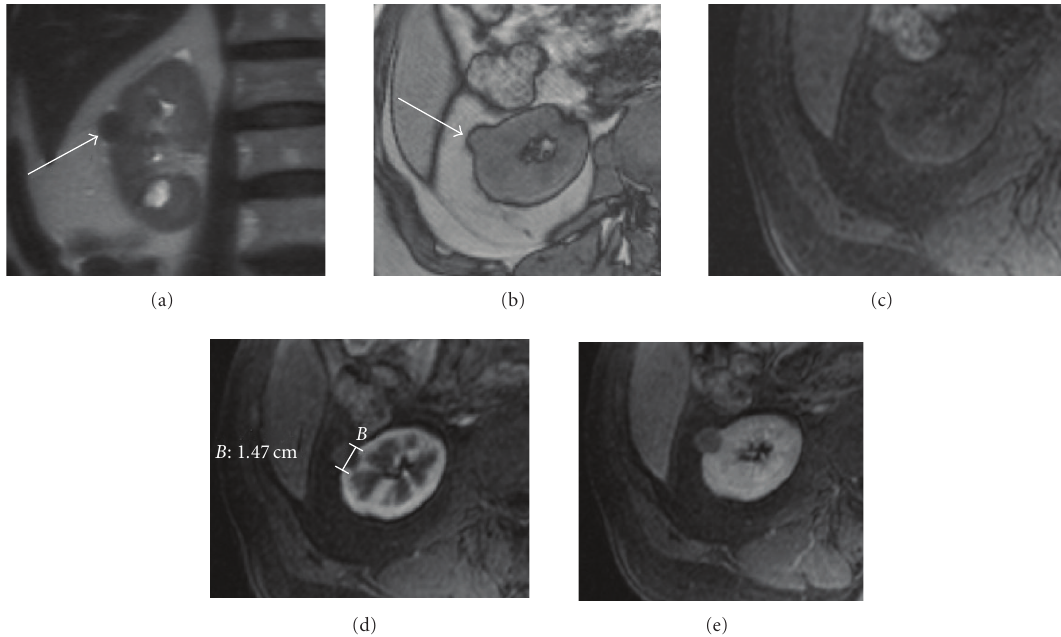
Figure 15: (a) Cor haste T2, (b) out of phase axial T1, (c) axial precontrast T1 with fat suppression, (d) early postcontrast axial T1 with fat saturation, and (e) axial postcontrast T1 with fat suppression. Small renal lesion on the lateral aspect of the upper pole of the right kidney shows a solid mass hypointense on T2 that does not present a loss of signal out of phase sequence and only a small enhancement on postcontrast sequences, consistent with a papillary renal